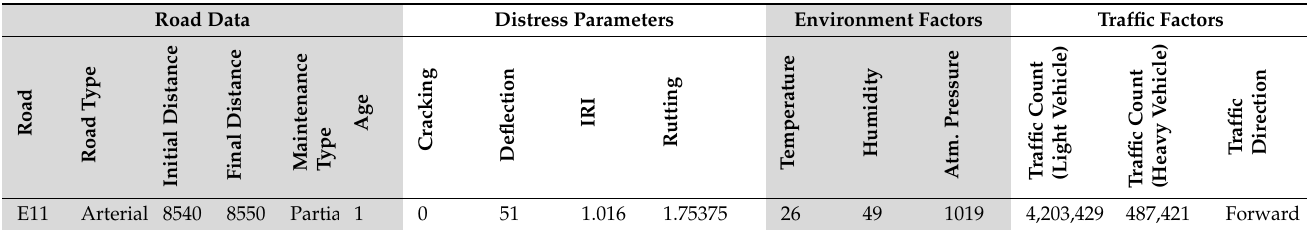
Table 3. An example of a data point in the